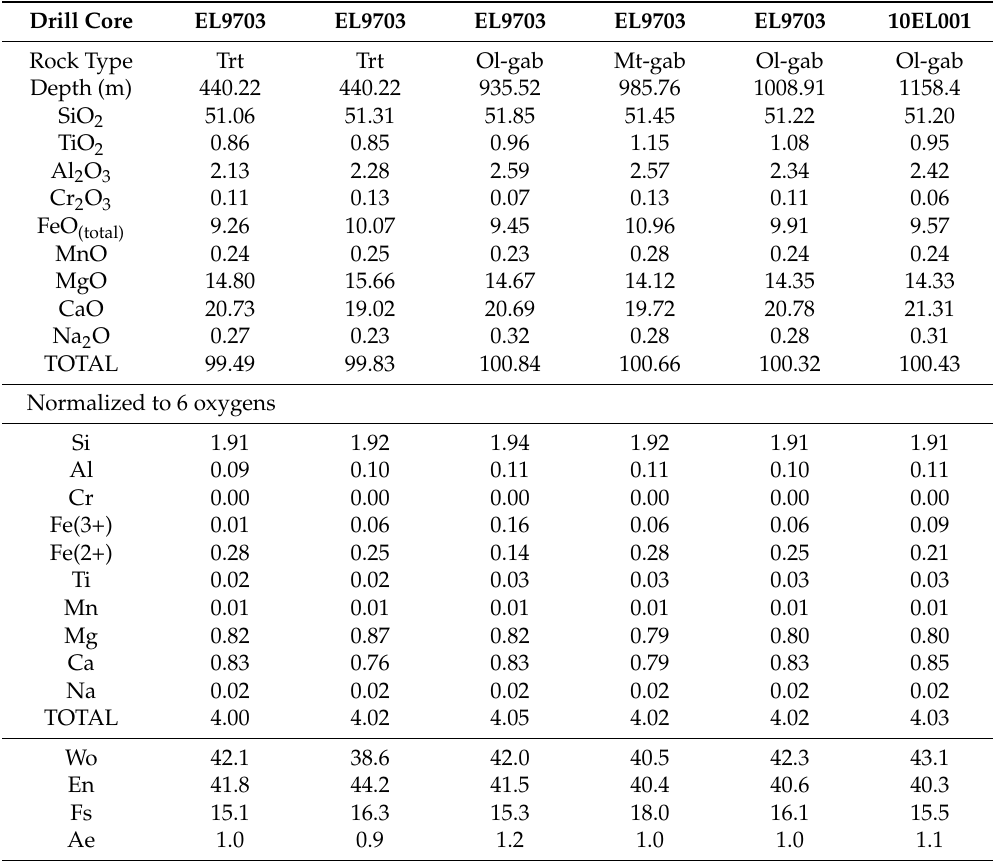
Table 3. Composition of clinopyroxene in the major rock types.